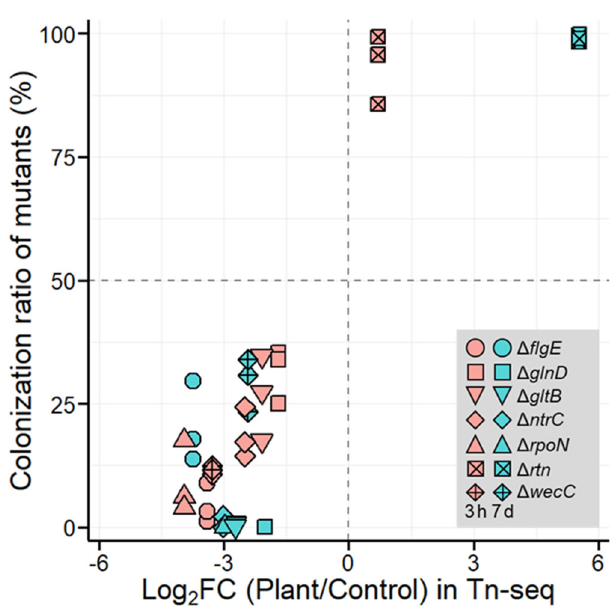
Fig. 6 Validation of Tn-seq results by the co-inoculation assay. Seven deletion mutants (shown in Table 1) were subjected to the co-inoculation assay with the wild-type strain; the colonization ratio of mutants was plotted against the results of corresponding genes in the